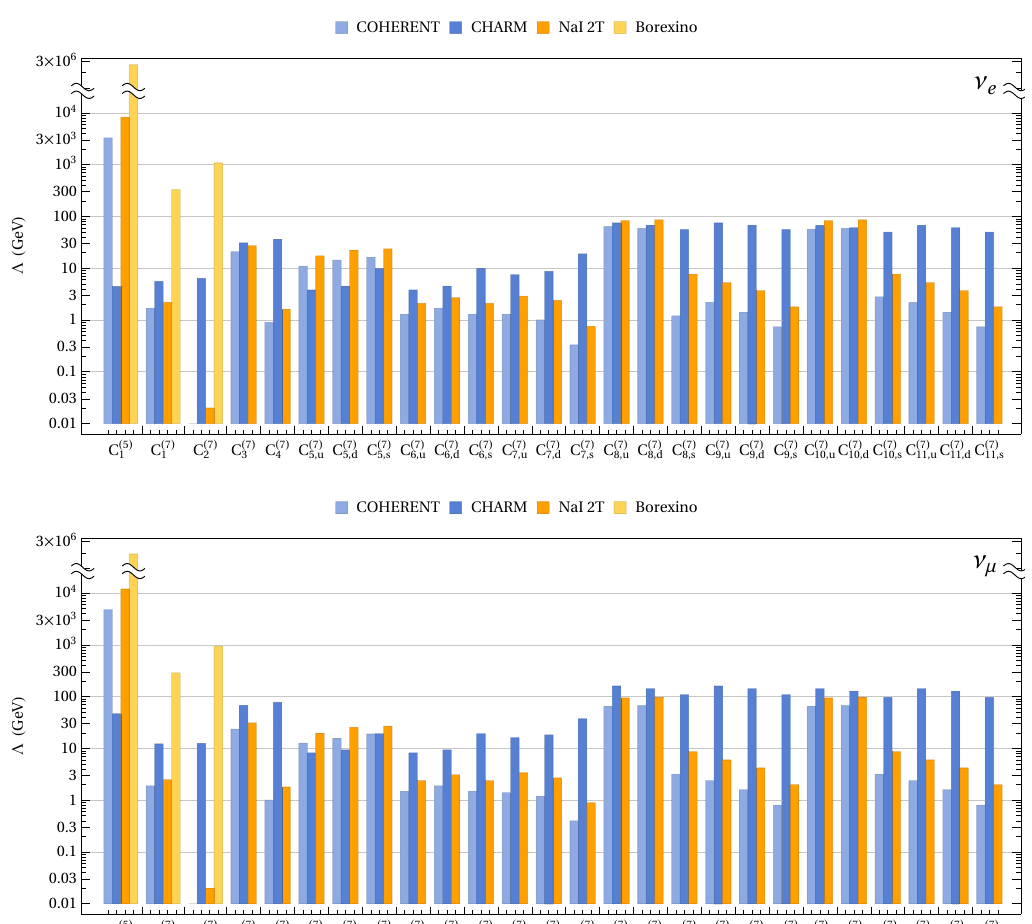
Figure 6 . Limits from COHERENT, CHARM, Borexino, and projected limits from a NaI 2T experiment on the scale Λ of dimension 5 and dimension 7 NSI operators for electron neutrinos (top) and muon neutrinos